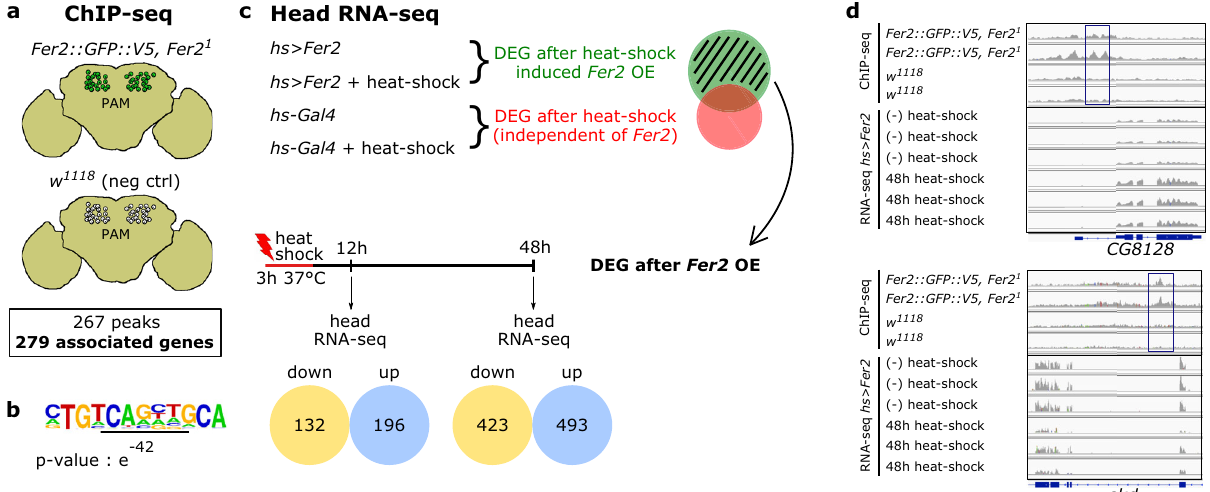
Fig. 3 Identi fi cation of Fer2 transcriptional targets through a combination of ChIP-seq and RNA-seq approaches. a ChIP-seq was performed on 14-day- old Fer2::GFP::V5, Fer2 1 fl ies. w 1118 fl ies were used as a negative control. n = 2 biological replicates per group. b A sequence containing an E-box (CANNTG, underlined) was found enriched by Fisher ’ s exact test in FER2 ChIP-seq peaks over w 1118 ChIP-seq. c Scheme of the whole-head RNA-seq analysis to identify DEG after heat shock-driven Fer2 transient overexpression. n = 3 biological replicates per group. The number of DEGs up- and downregulated after heat shock are shown . d Examples of ChIP-seq and RNA-seq data (48 h) for two Fer2 direct targets, CG8128 and skd . The rectangles indicate ChIP- seq